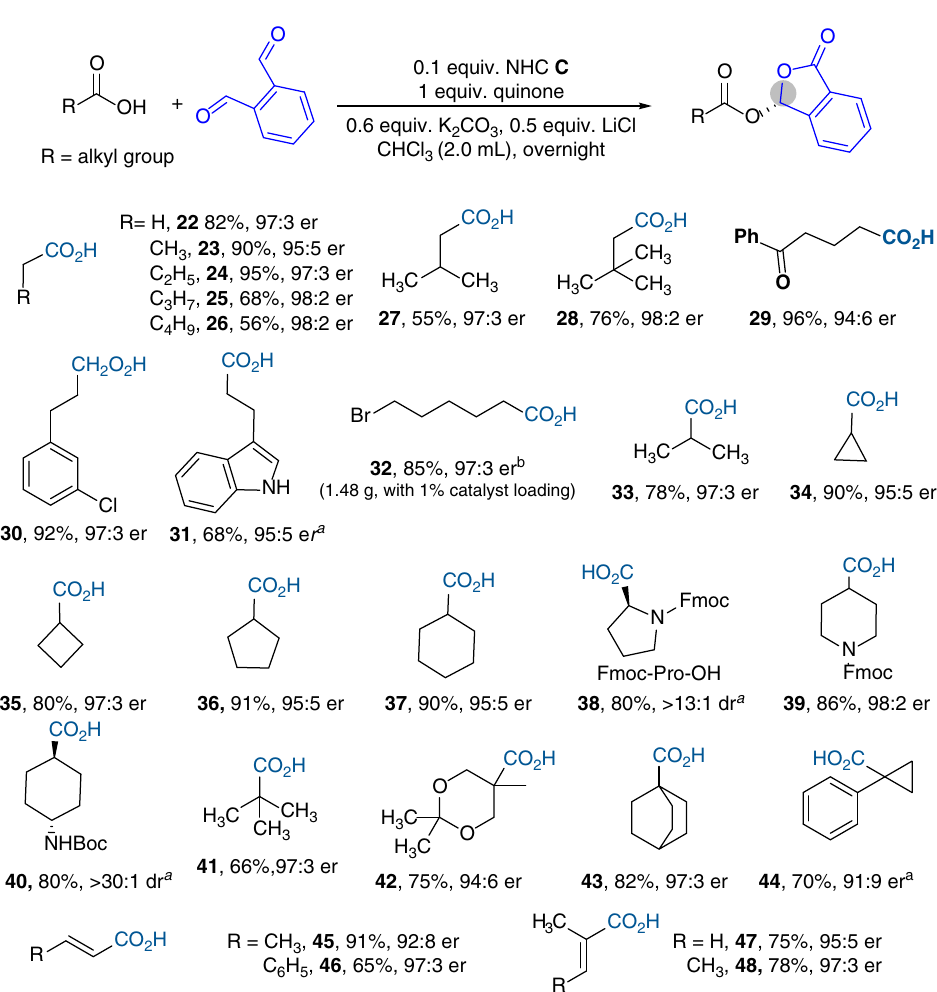
Fig. 3 Scope of alkyl acids. Reaction conditions: alkyl acid (0.1 mmol), o -phthalaldehyde (0.15 mmol), 0.1 equiv. NHC C , 1 equiv. quinone, 0.6 equiv. K 2 CO 3 , 0.5 equiv. LiCl, CHCl 3 (2 mL), rt, 12 h. Yields determined by isolation. er determined by HPLC, a under − 30 °C. b under − 10 °C